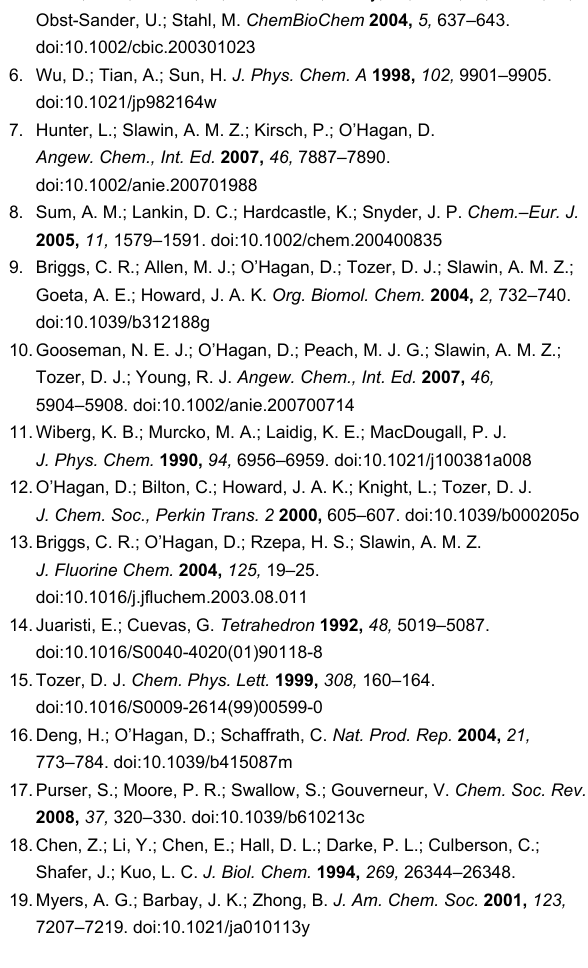
are underway in the author’s laboratory, and details of these in- vestigations will be reported in due